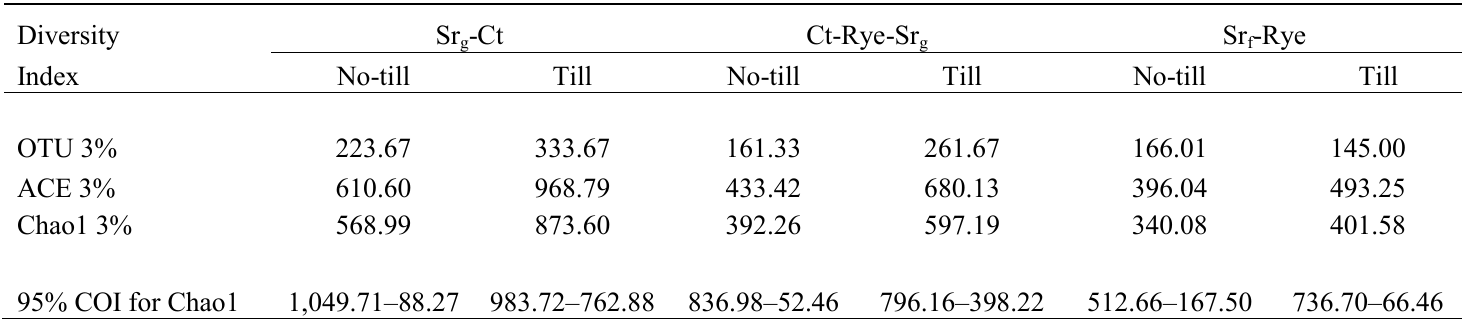
Table 4. Bacterial diversity as affected by dryland cropping systems and tillage in a semiarid sandy soil.